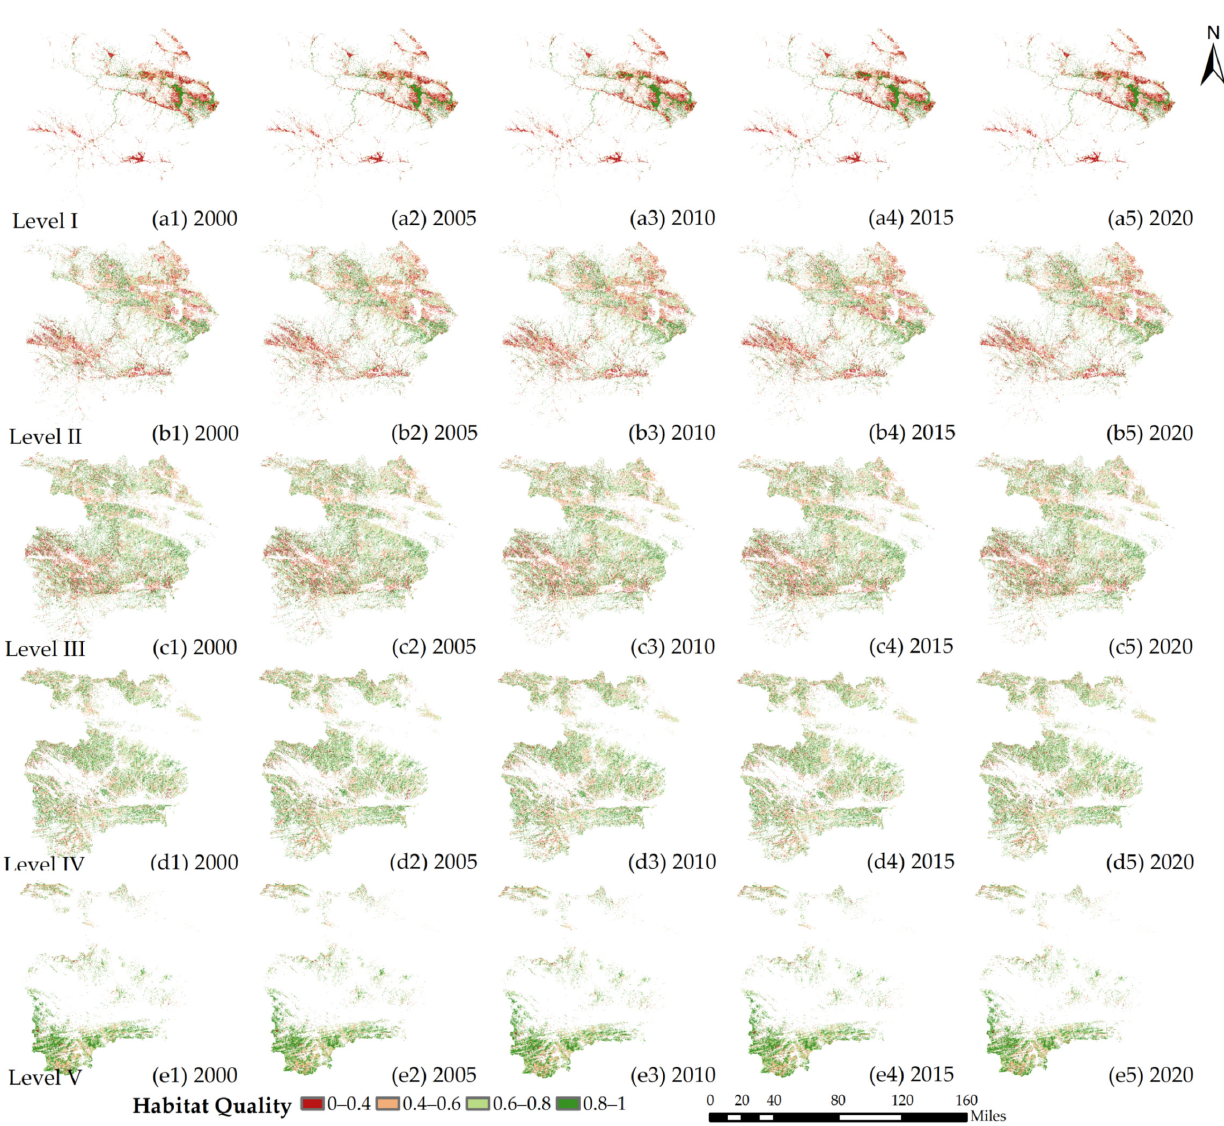
Figure 13. Distribution map showing habitat quality for each terrain index level in Shiyan from 2000 to 2020. Level I: ( a1 ) 2000, ( a2 ) 2005, ( a3 ) 2010, ( a4 ) 2015, and ( a5 ) 2020; level II: ( b1 ) 2000, ( b2 ) 2005, ( b3 ) 2010, ( b4 ) 2015, and ( b5 ) 2020; level III: ( c1 ) 2000, ( c2 ) 2005, ( c3 ) 2010, ( c4 ) 2015, and ( c5 ) 2020; level IV: ( d1 ) 2000, ( d2 ) 2005, ( d3 ) 2010, ( d4 ) 2015, and ( d5 ) 2020; level V: ( e1 ) 2000, ( e2 ) 2005, ( e3 ) 2010, ( e4 ) 2015, and ( e5 ) 2020.